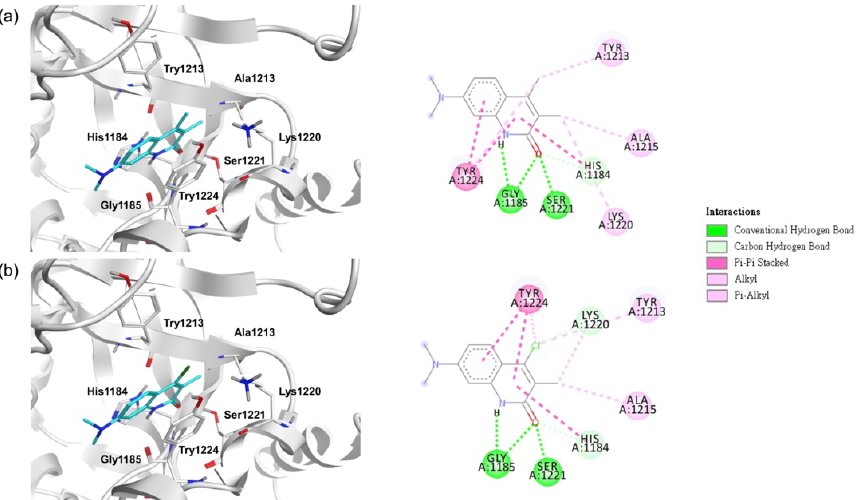
Figure 7. The docking modes of NSC319963 and NSC295092. ( a ) Docking model of NSC295092 and 2D interaction map. ( b ) Docking model of NSC319963 and 2D interaction map. 3.5. NSC319963 Inhibits Cell Growth on Colony Formation in CRC Cell Lines